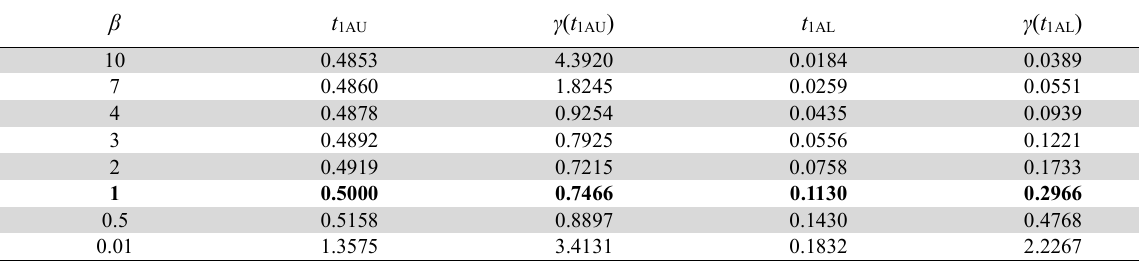
Results of extra convexity tests with broader range of β